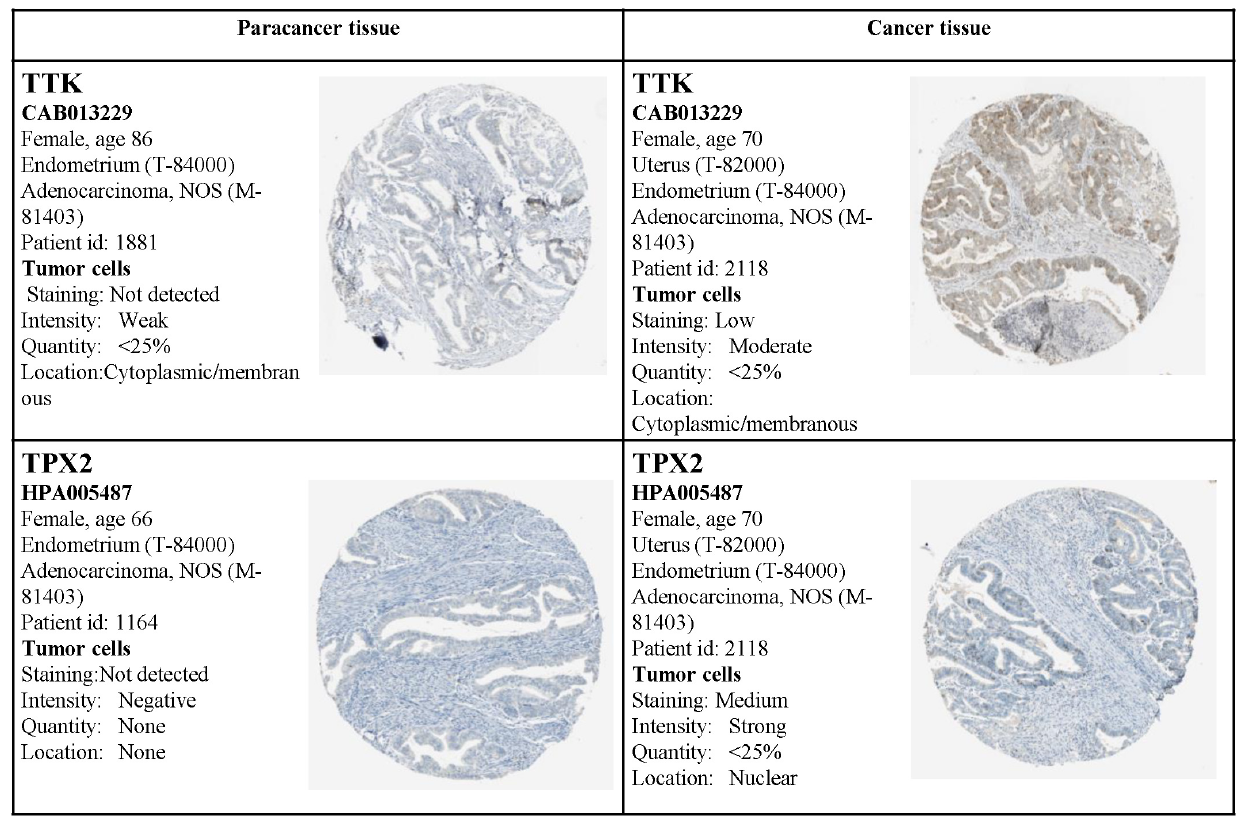
FIGURE 14 | Validation of the four hub genes by the Human Protein Atlas (HPA) database. Data for BUB1Band NDC80 were not available in the HPA